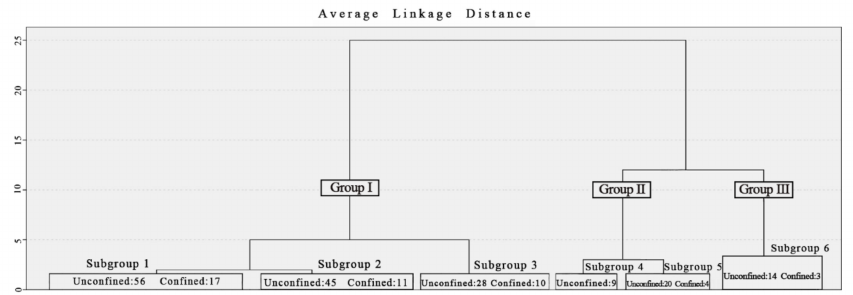
Figure 4. Dendrogram resulting from the hierarchical cluster analysis (HCA).